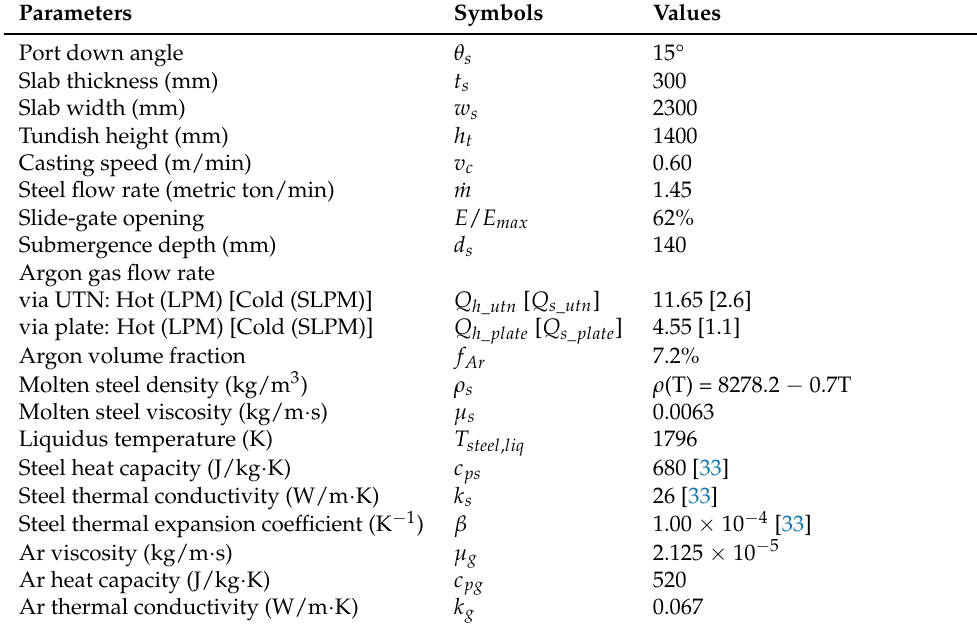
Table 1. Caster dimensions and process